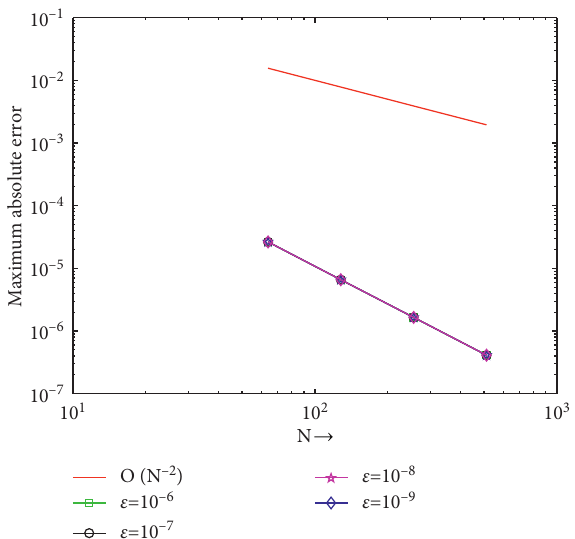
Figure 6: Log-log plot for Example 3 when μ � 10 − 7